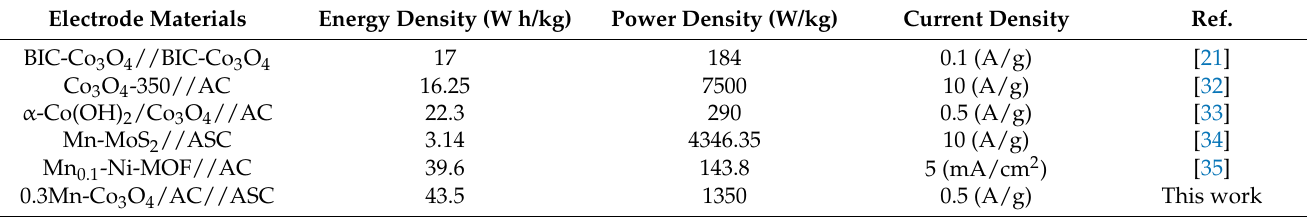
Figure 4. Electrochemical characterizations of ASC ( a ) Schematic ( b ) CV curves of 0.3Mn-Co 3 O 4 and active carbon ( c ) CV curves with various scan rates ( d ) CV curves with various voltage windows ( e ) GCD curves ( f ) Nyquist plots ( g ) Ragone plot ( h ) Cycling performance. Table 2. Comparison of energy density and power density of 0.3Mn-Co 3 O 4 device with previous reports.